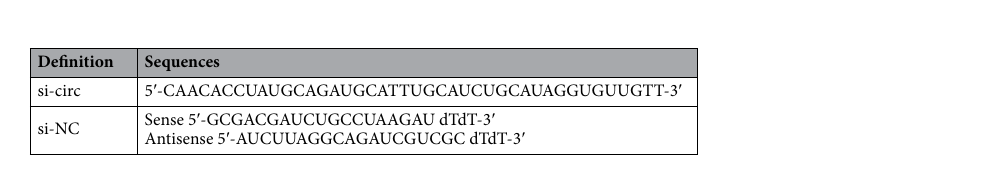
Table 3. Sequences of siRNAs used in this